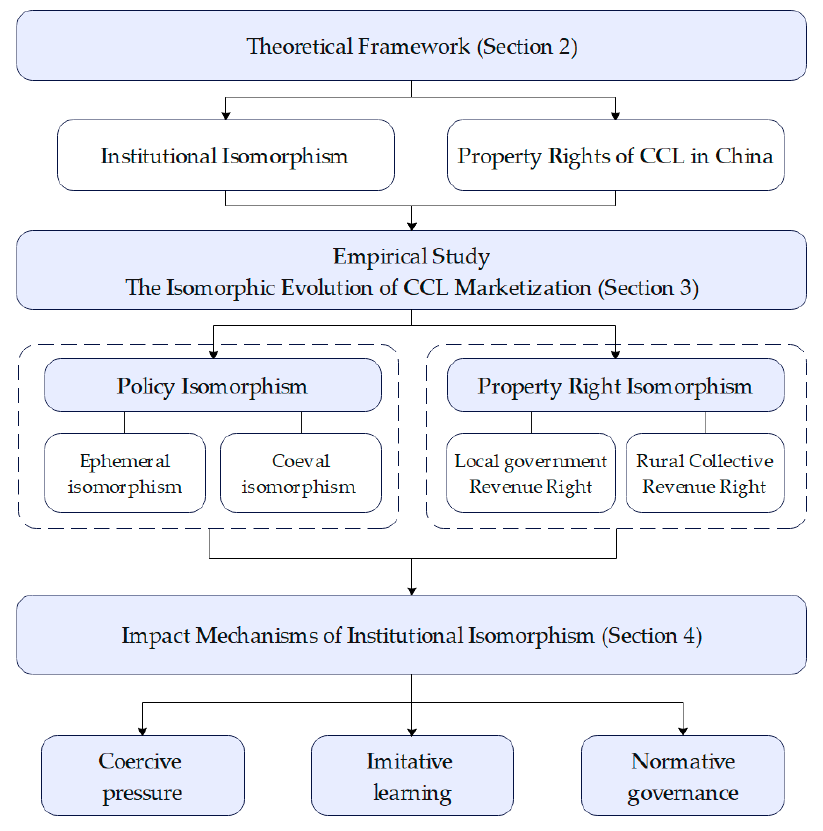
Figure 2. The technical route diagram.